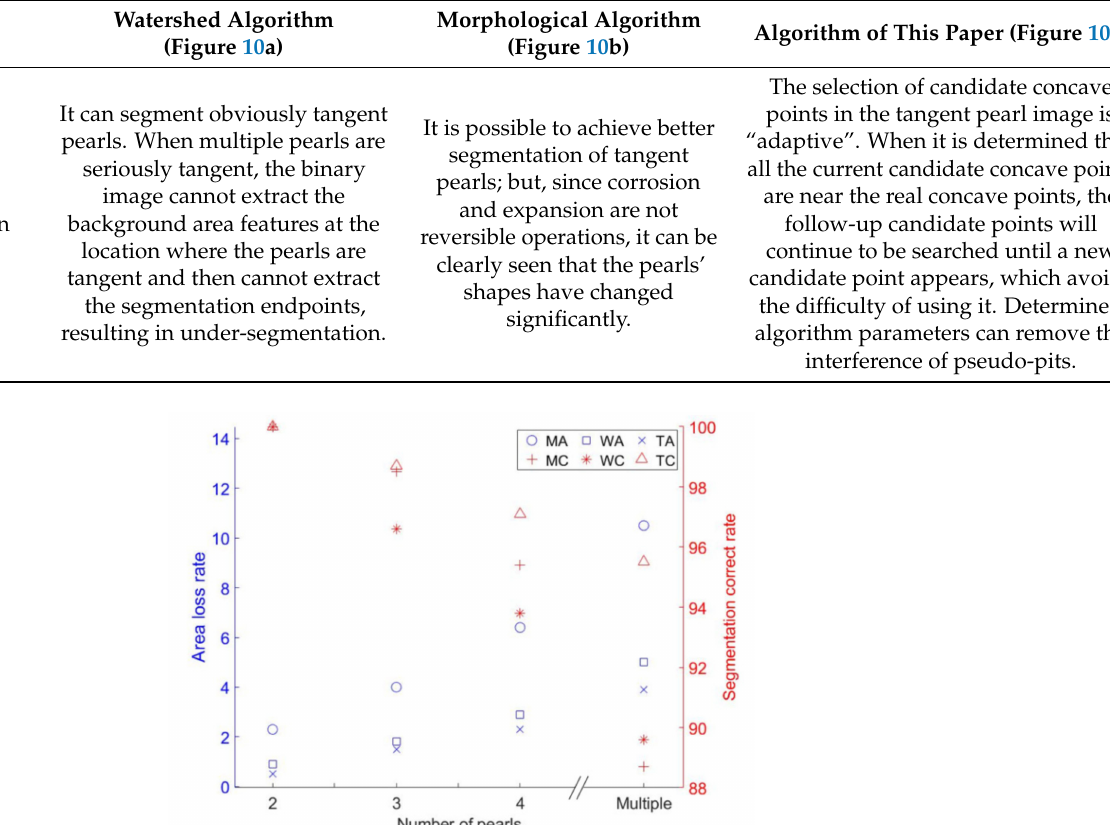
Table 3. Three algorithm segmentation results.